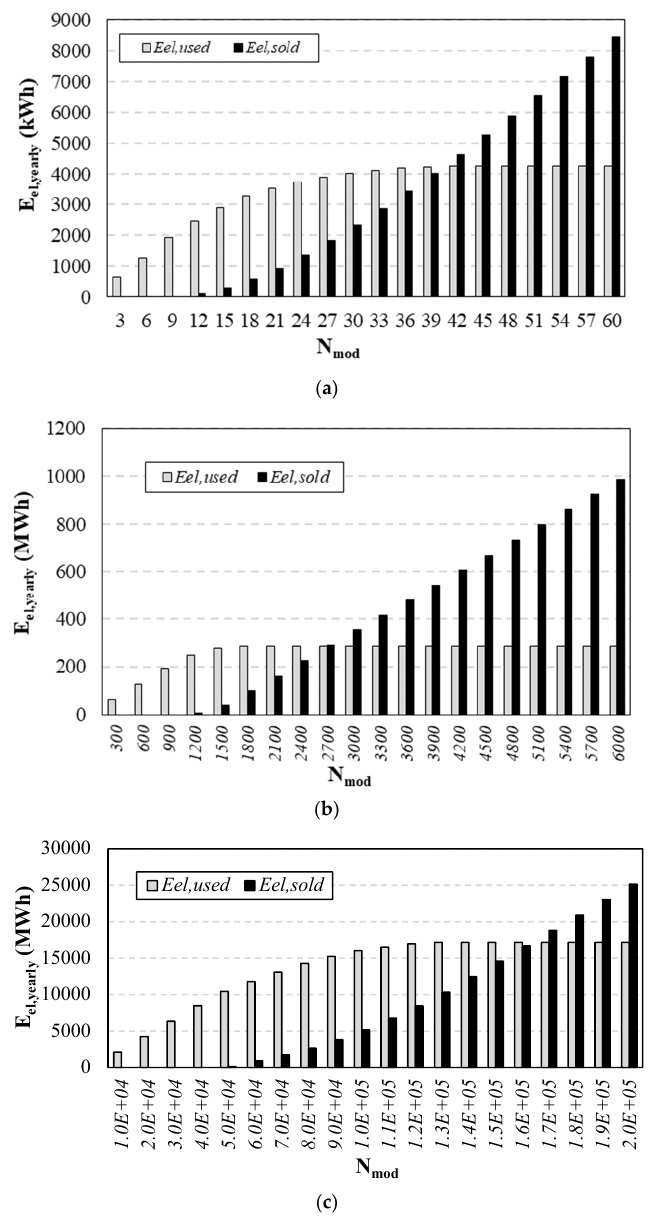
Figure 6. Trends of the annual electrical energy used and sold by varying the number of modules for the three users: ( a ) house; ( b ) hotel; and ( c ) industry.